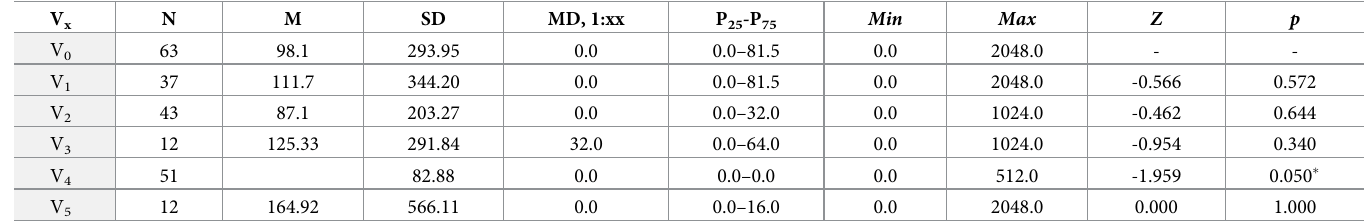
Table 2. Level of IgG IHA over time and difference of respective levels compared to baseline. Vx = follow-up visit with V0 = baseline, N = number, M = mean, SD = standard deviation; MD = median, P 25 /P 75 = 25 th & 75 th percentile, Min. = minimum, Max. = maximum, Z = Wilcoxon’s Z-Value, p -value = significance level with � considered significant.